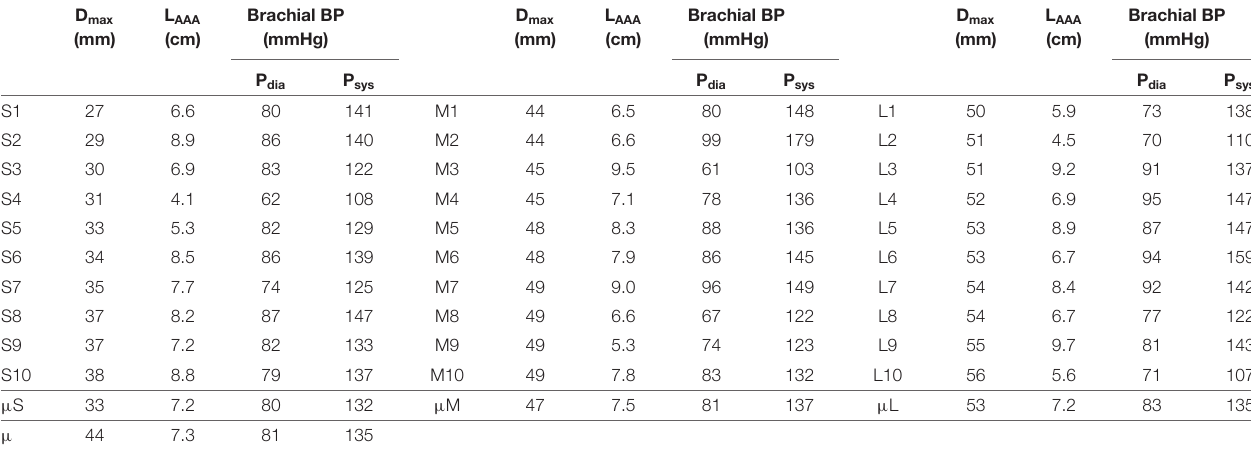
TABLE 1 | Summary of the maximum diameter (D max ), length of the AAA geometry (L AAA , elongation excluded) and brachial diastolic blood pressure (P dia ), and systolic blood pressure (P sys ) for all 30 patients and the (group) average ( µ ).